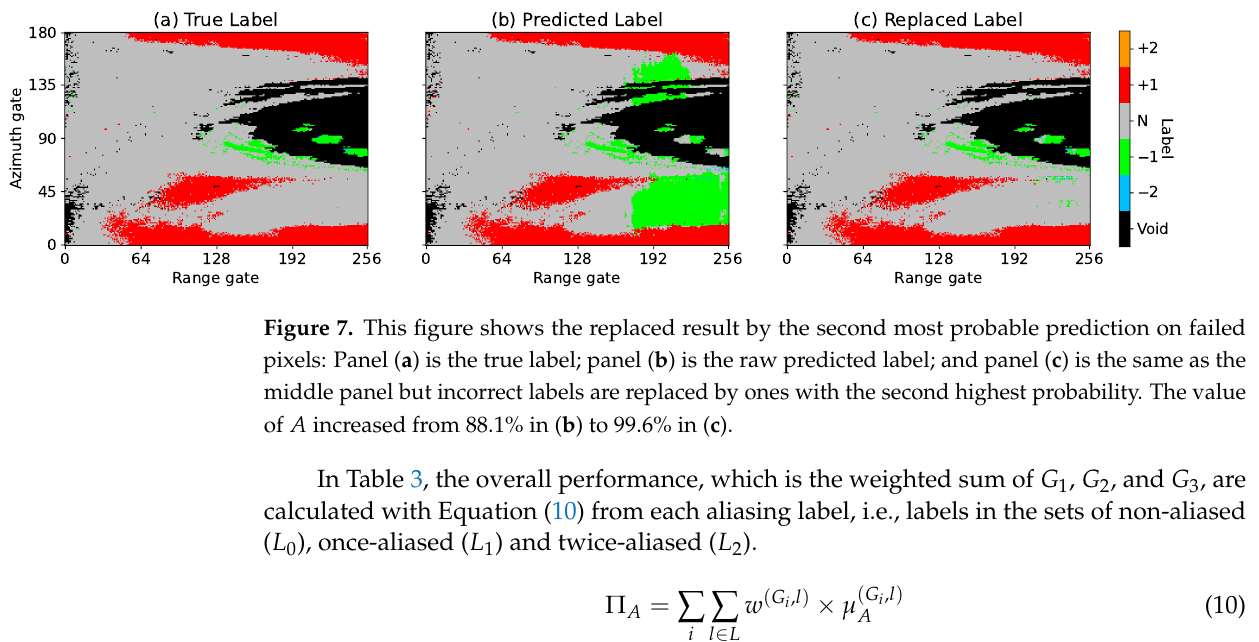
Figure 6. A similar scan to Figure 5 but the CNN model succeeded the prediction of aliasing labels (green patch in panel (b) of Figure 5). Panel ( a ) shows the true label, which is synthesized using a 1.32 ◦ -EL scan from the KTLX on 16 January 2017 06:33 UTC. In panel ( b ), the green patch near azimuths 0–45 ◦ at range gates 180–256 from panel ( b ) of Figure 5 is now correctly identified. Panels ( c – h ) represent the probability of each label from the CNN model. If one replaces the incorrect pixels with labels that have the second highest probability, the accuracy would have increased from 88.1% to 99.7%. The replaced result is shown in Figure 7. Panel (a) represents the true label, panel (b) shows the raw predicted label, and panel (c) is the replaced label from panel (b) by ones with the second most probable prediction on failed ones. Out of the 168 scans among the total of 495 test data (non-speckle), 80.9% of them have the correct label as the second most probable prediction. Because of the complexity of the CNN model, it is extremely difficult to find an explanation for these false predictions. However, it is clear that the performance of the CNN model can be improved significantly if the second most probable predictions were selected under these circumstances. It must be emphasized here that this cannot be recovered in practice. This example is presented here only to illustrate the potential for improvements.